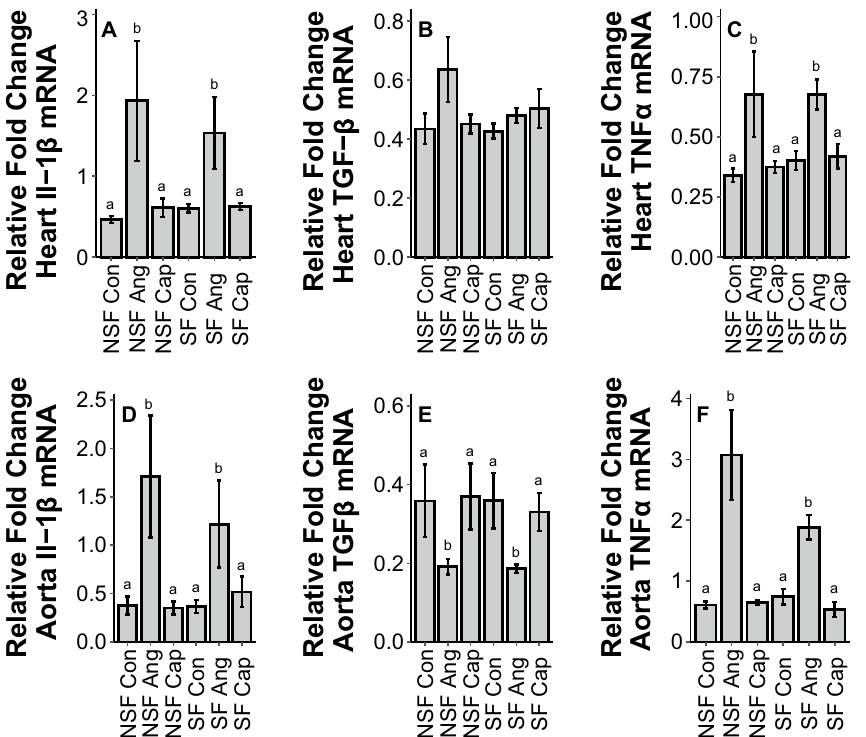
Figure 2. Effects of sleep fragmentation, RAS manipulation, and their interaction on Il-1β, TGFβ, and TNFα gene expression in circulatory tissues, heart ( A , B , C ) and aorta ( D , E , F ). Samples sizes are ( A ) NSF-Con n = 10, NSF-Ang n = 10, NSF-Cap n = 10, SF-Con n = 9, SF-Ang n = 9, and SF-Cap n = 10, ( B ) NSF-Con n = 10, NSF-Ang n = 10, NSF-Cap n = 10, SF-Con n = 10, SF-Ang n = 8, and SF-Cap n = 10, ( C ) NSF-Con n = 10, NSF-Ang n = 9, NSF-Cap n = 10, SF-Con n = 10, SF-Ang n = 9, and SF-Cap n = 9, ( D ) NSF-Con n = 11, NSF-Ang n = 10, NSF-Cap n = 9, SF-Con n = 9, SF-Ang n = 9, and SF-Cap n = 10, ( E ) NSF-Con n = 11, NSF-Ang n = 10, NSF-Cap n = 10, hoc tests. Data shown as means ± 1 SE for each group and differing lowercase letters denotes p <